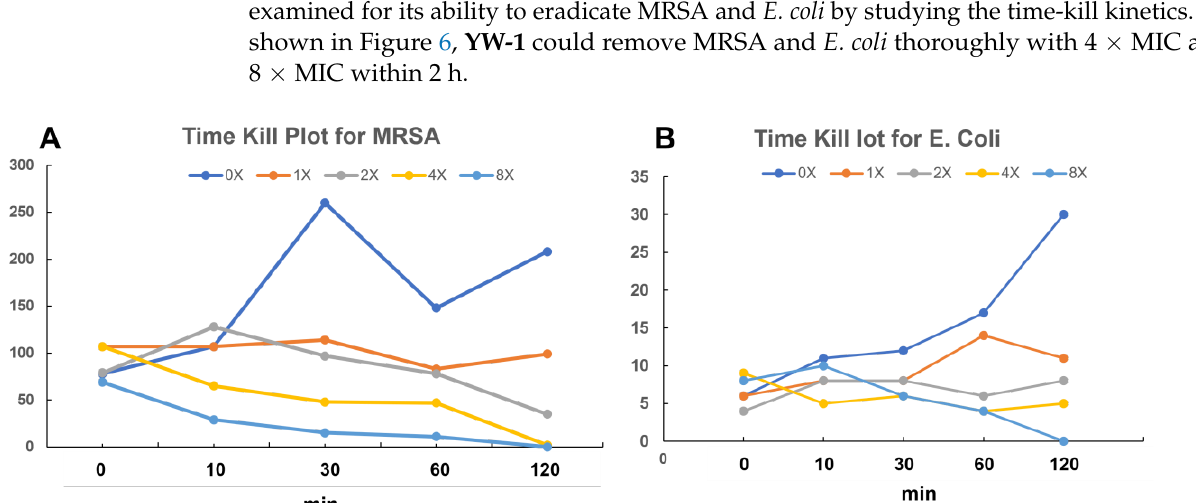
Figure 6. Time-kill kinetics of YW-1 toward MRSA ( A ) and E. coli ( B ).